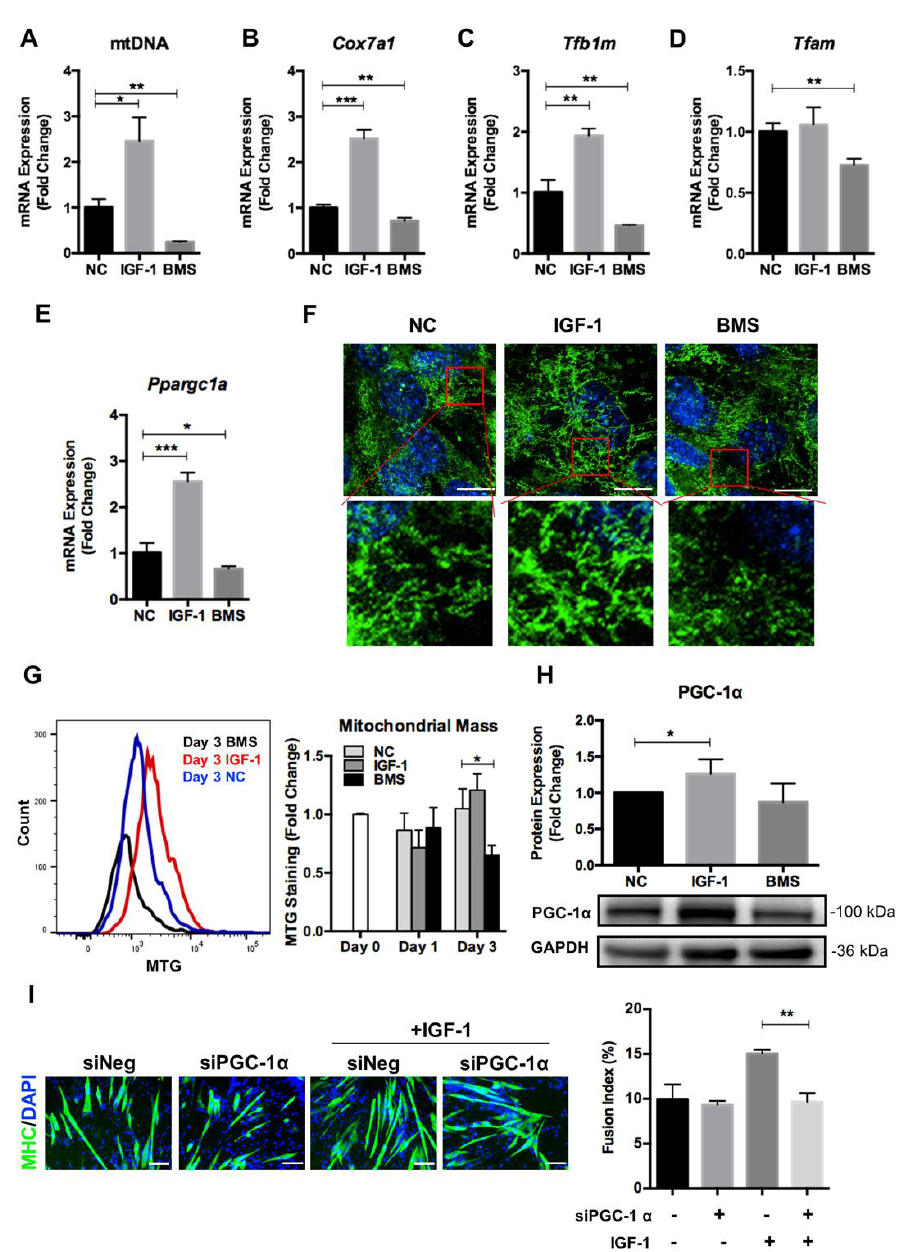
Figure 3. IGF-1 signaling regulates mitochondrial biogenesis during myogenic differentiation. ( A ) Mitochondrial DNA (mtDNA) content in C2C12 myotubes after 3 days of differentiation. ( B – E ) mRNA expression of Cox7a1 ( B ), Tfb1m ( C ), Tfam ( D ), and Ppargc1a ( D ) genes in C2C12 cells treated with DMSO (NC), 10 ng/mL IGF-1, or 200 nM BMS after 3 days of differentiation. ( F ) The Mito Tracker Green (MTG) staining of C2C12 cells after 3 days of differentiation. ( G ) The mitochondrial mass evaluation by MTG staining and quantified by FACS. ( H ) Representative immunoblots and quantitative analysis of PGC- 1α and GAPDH in C2C12 cells after 3 days of differentiation. ( I ) Immunofluorescent staining of MHC (green) and DAPI (blue) and quantitative analysis of the fusion index for siNeg and siPGC 1α C2C12 cells with or without IGF-1 treatment after 5 days of differentiation. Scale bar = 100 μm. Data represent means ± SD. * p < 0.05, ** p < 0.01, and *** p < 0.001.